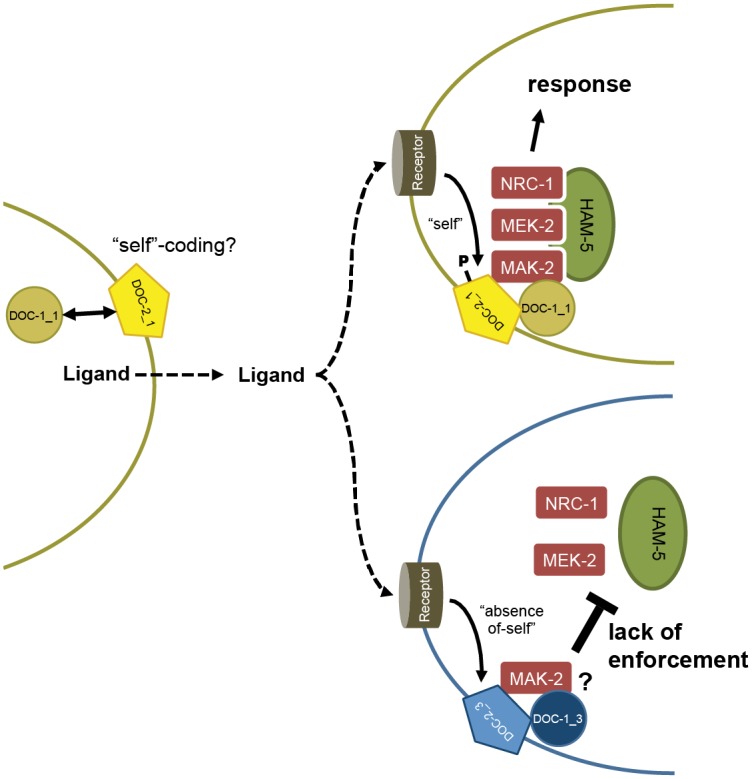
Model for DOC-1 and DOC-2 function in long-distance kind discrimination.This model assumes that during conidial germination, N. crassa germlings release a ligand that acts as a signal for potential interaction partners. The ligand/receptor or other components of the recognition pathway might be modified and coded as “self” by DOC-1/DOC-2 of the sending cell. In the receiving cell, the ligand activates a receptor. The DOC-1/DOC-2 system of the receiving cell functions in quality control. If the signal passes quality control, oscillation of the assembled MAK-2 complex is enforced and the signal-receiving cell shows chemotropic interactions (top). If the signal does not pass quality control, the DOC-1/DOC-2 system of the receiving cell prevents enforcement of MAK-2 oscillation, and, therefore, the receiving cell does not respond to the presence of a potential fusion partner (bottom).